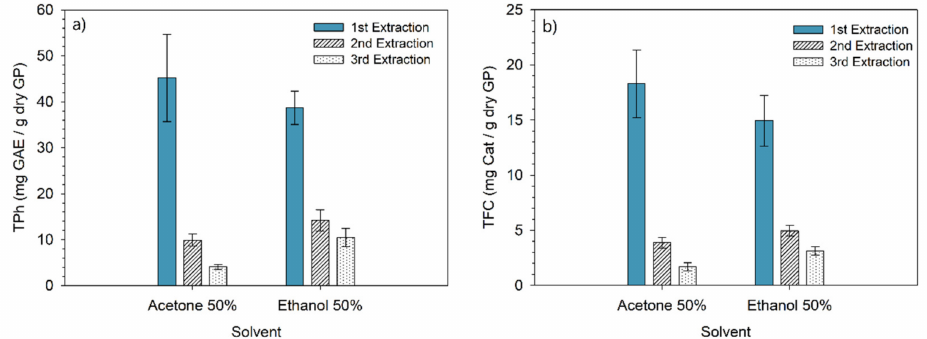
Figure 9. ( a ) Total phenolic content (mean ± standard deviation) and ( b ) total flavonoid content (mean ± standard deviation) of grape pomace obtained over three consecutive extractions with ethanol and